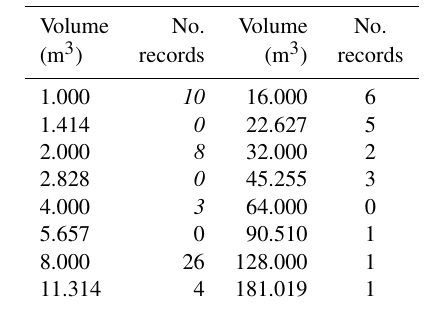
Table 3. List of the grouped volumes of the surveyed blocks on the slope of Becco dell’Aquila site. All the blocks belong to list F ; the blocks that are larger than V t , in normal font, belong to the reduced list F ∗ . The blocks in italic are those that are not part of the reduced list F ∗ .